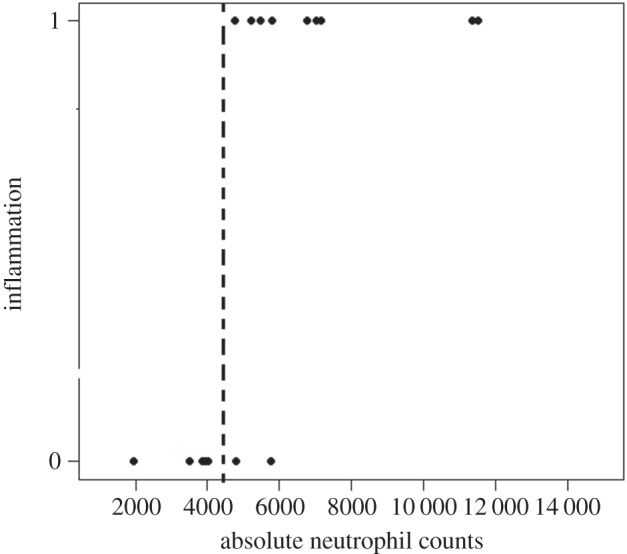
Presence or absence of swelling in terms of numbers of circulating neutrophils per microlitre of blood of six-month-old California sea lion pups.